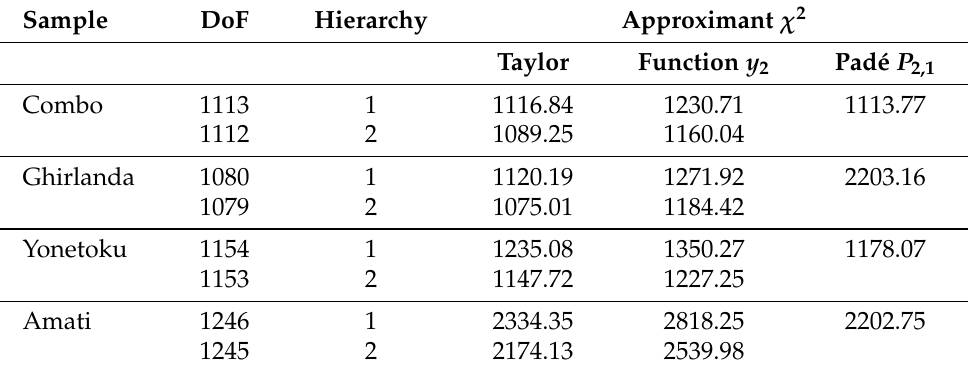
Table 6. χ 2 values of the cosmographic fits performed over the considered approximants. For each GRB correlation, the number of degrees of freedom (DoF) and the considered hierarchy are reported. Correlations are sorted for increasing values of the ratio χ 2 /DoF with respect to the Taylor hierarchy 1